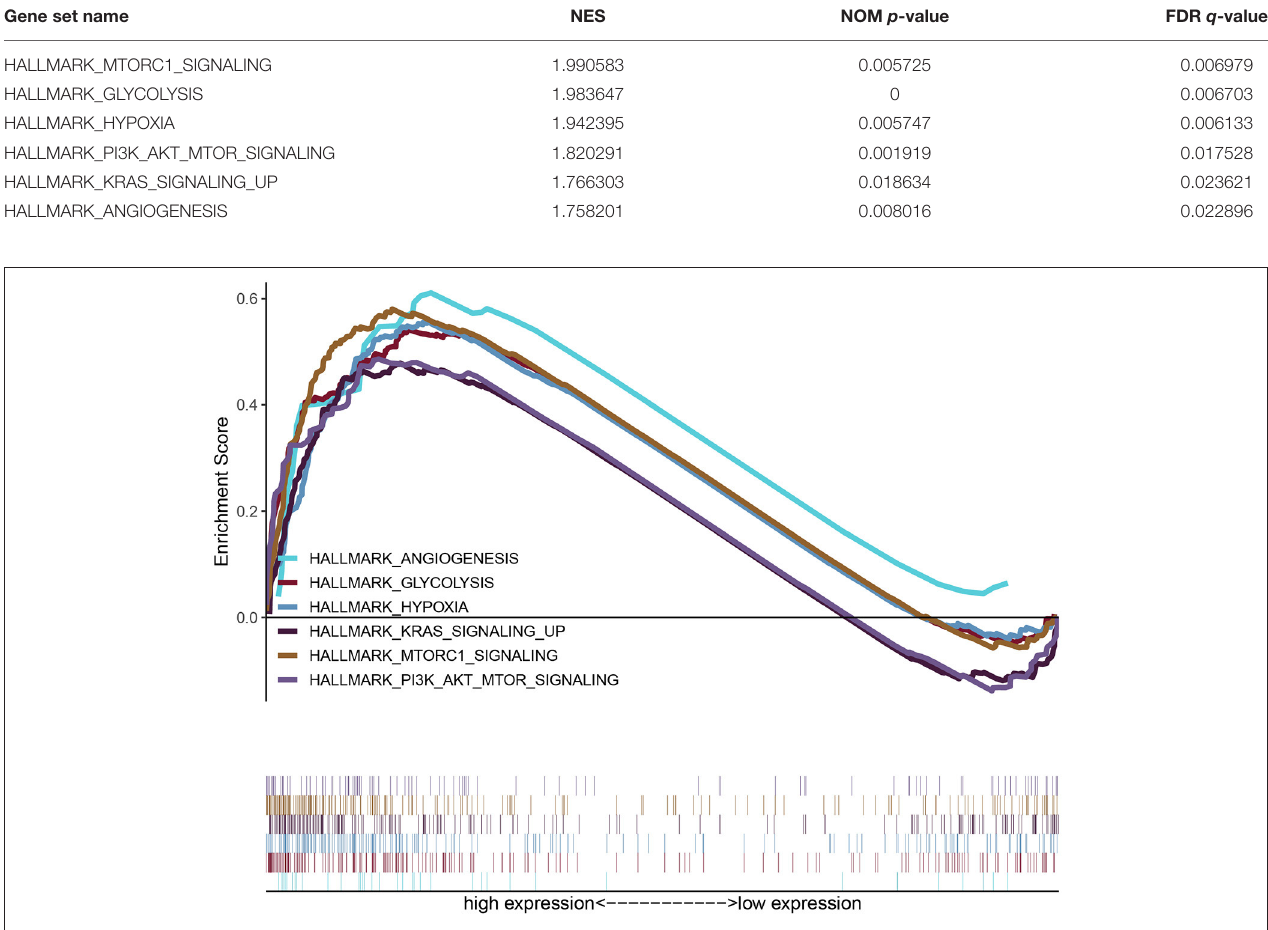
that, unlike PYGL, neither PYGM or PYGB exhibited a